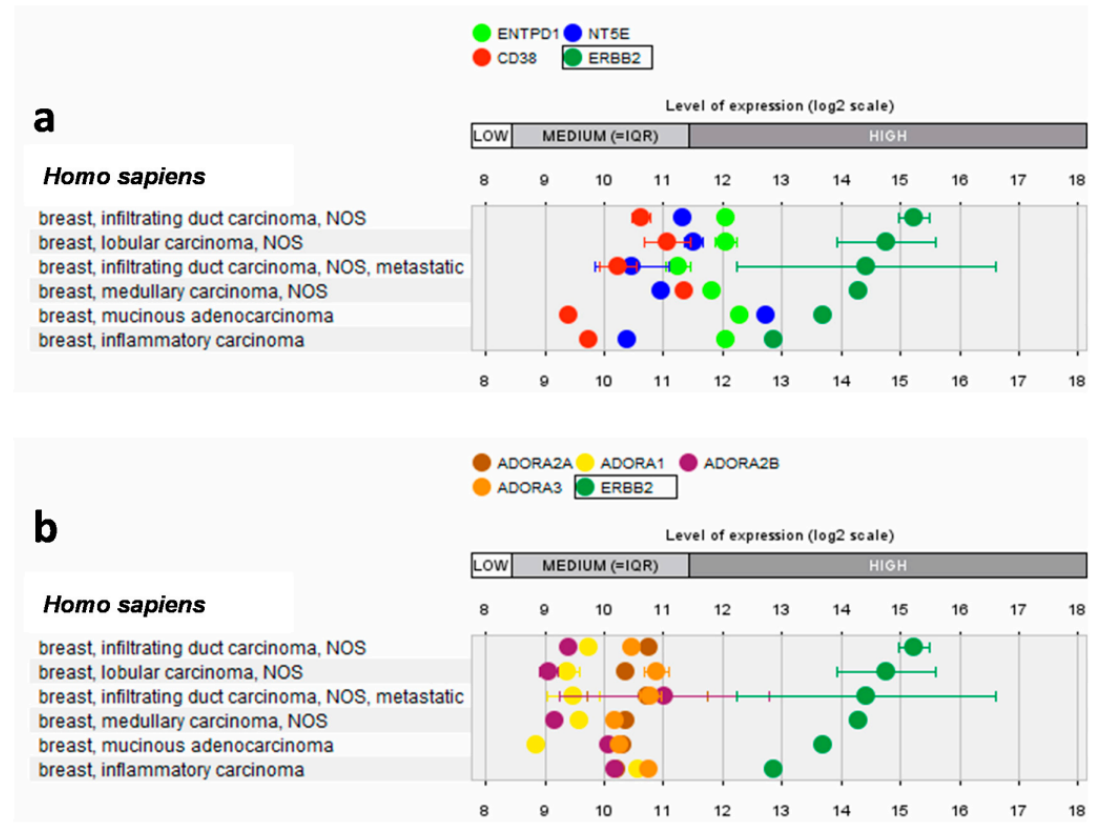
Figure 1. Expression of genes involved in eADO production and signaling in HER2-positive breast cancers. The magnitude of expression of ectonucleotidases involved in eADO production ( ENTPD1 , CD39; NT5E , CD73; CD38) ( a ) and adenosine receptors (ADORA2A, ADORA1, ADORA2B, ADORA3) ( b ) was investigated among ERBB2+ breast tumors from public transcriptomic repositories by